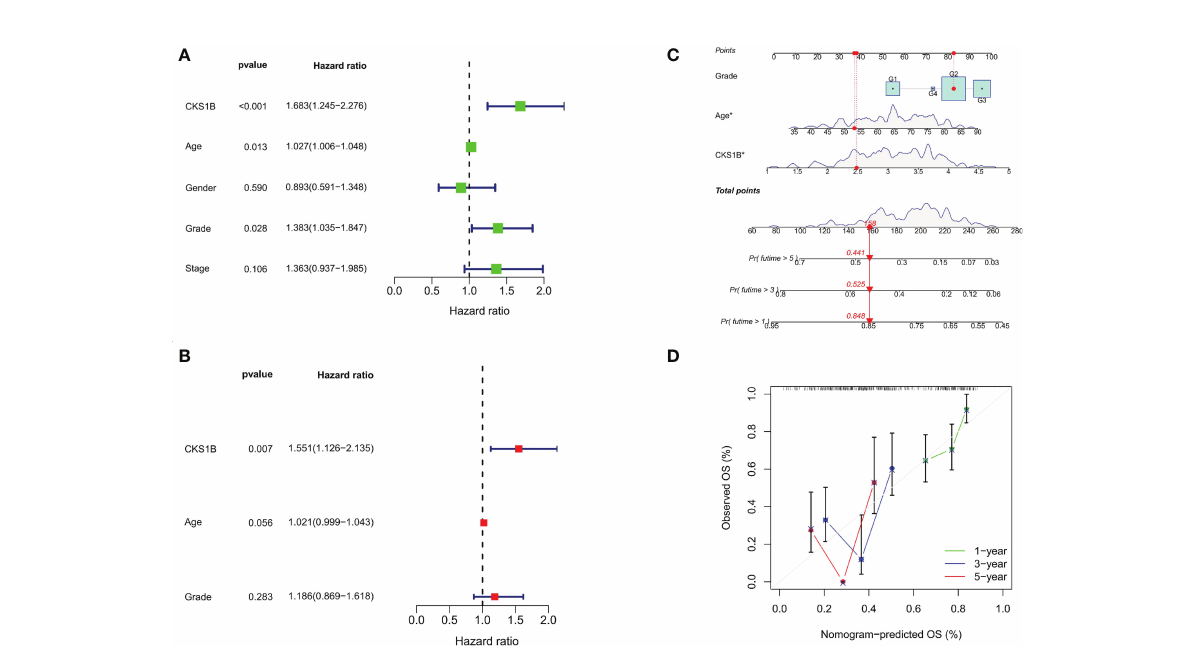
FIGURE 2 The independent prognostic analysis and nomogram construction in pancreatic cancer. (A) Univariate Cox regression analysis for CKS1B and clinical characteristics. (B) . Multivariate Cox regression analysis for CKS1B and clinical features. (C) The nomogram consists of age, grade, and CKS1B expression. (D) The calibration curve for evaluating model accuracy. (*P <